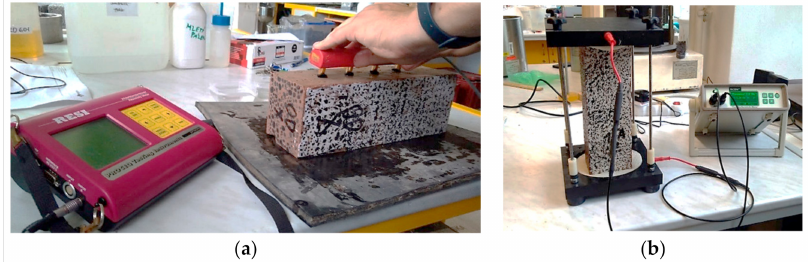
Figure 4. Testing of the surface resistivity (SR) with the Wenner probe ( a ); bulk resistivity (BR) with RCON ( b